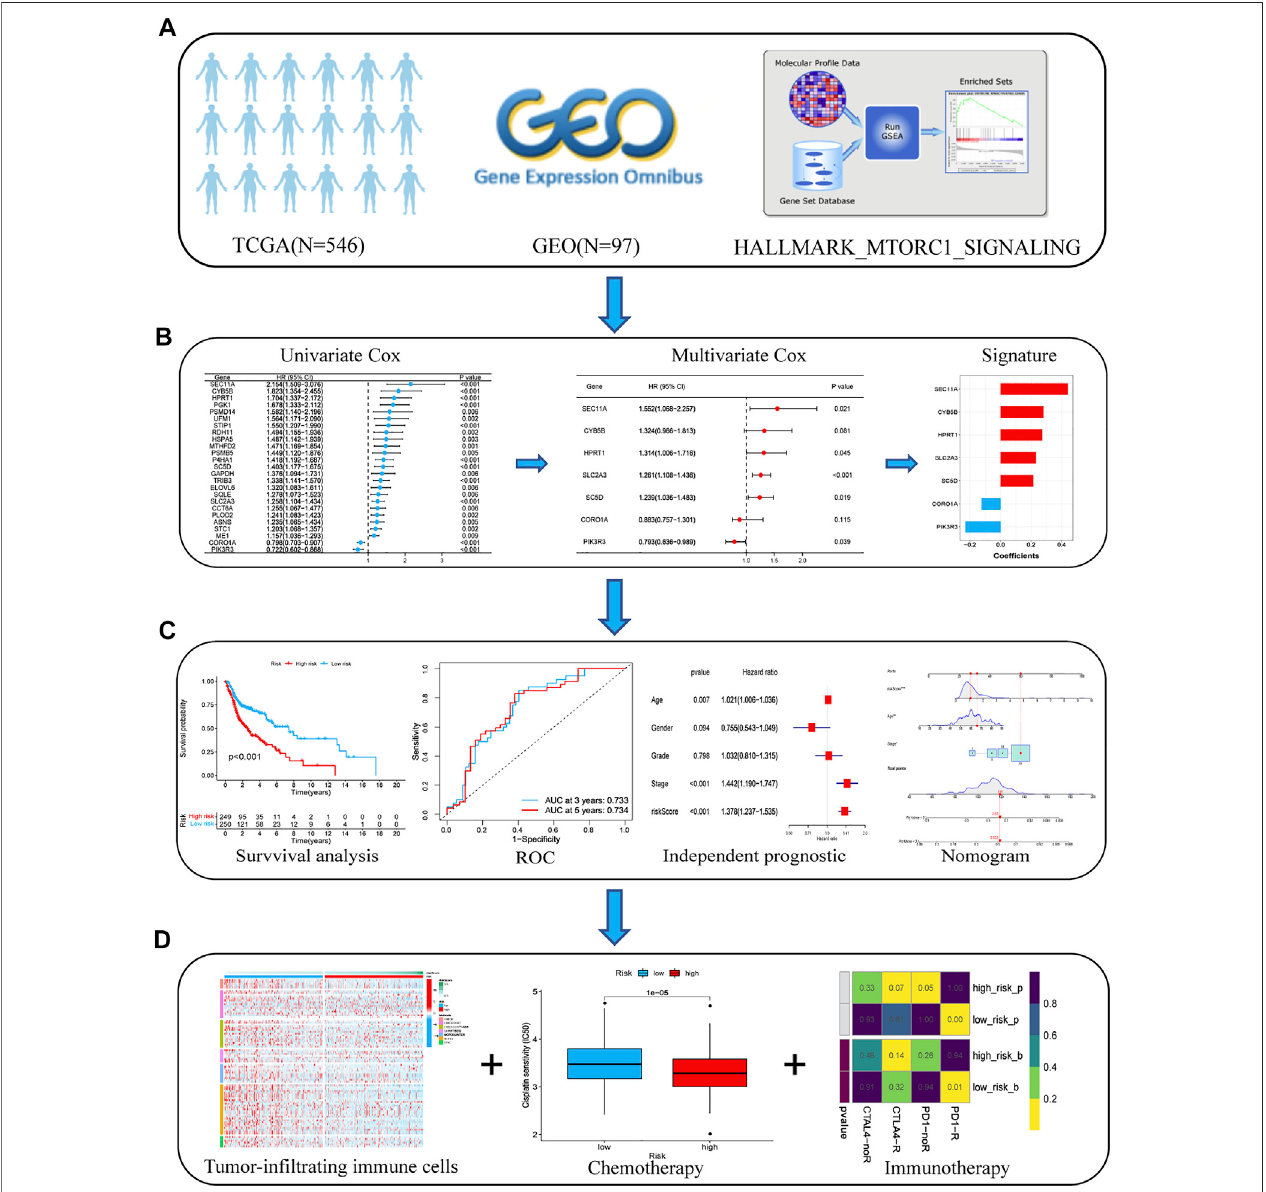
FIGURE1| Flowchartoftheanalysesperformedinthisstudy. (A) TranscriptomedataandcorrespondingclinicalinformationfromTCGAandGEOdatabaseswere downloaded. (B) Univariate and multivariate Cox regression analyses were performed to select prognostic genes and build an optimal prognostic signature. (C) K – M survival curves and the log-rank test were used to analyze the differences in survival times between the low- and high-risk patients. An ROC curve was plotted to investigate the prediction accuracy of the risk model. The nomogram prediction model was constructed based on the risk score and independent clinical factors, including age and AJCC stage. (D) We compared the in fi ltration status of immunocytes between the low- and high-risk groups using the presently acknowledged algorithms. Chemotherapeutic and immunotherapeutic sensitivities of patients with HNSCC were calculated and compared between the high- and low-risk groups. Abbreviations:AJCC, AmericanJointCommitteeonCancer;GEO,GeneExpressionOmnibus;HNSCC, headandnecksquamouscellcarcinoma;K – M, Kaplan – Meier; ROC, receiver operating characteristic; TCGA, The Cancer Genome Atlas.